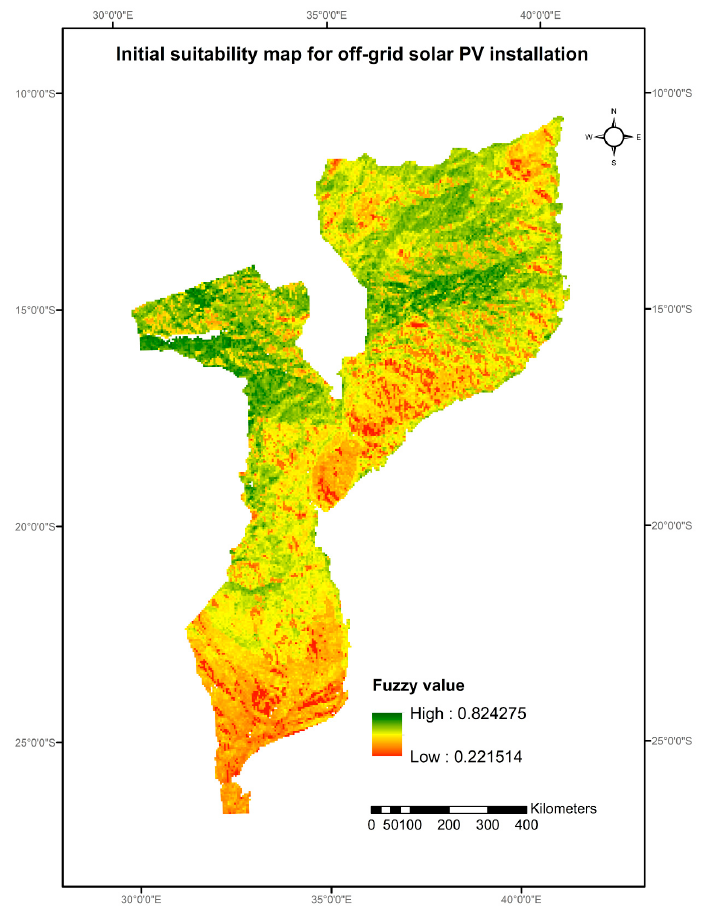
Figure 11. Initial site suitability map for off-grid solar PV microgrid deployment.